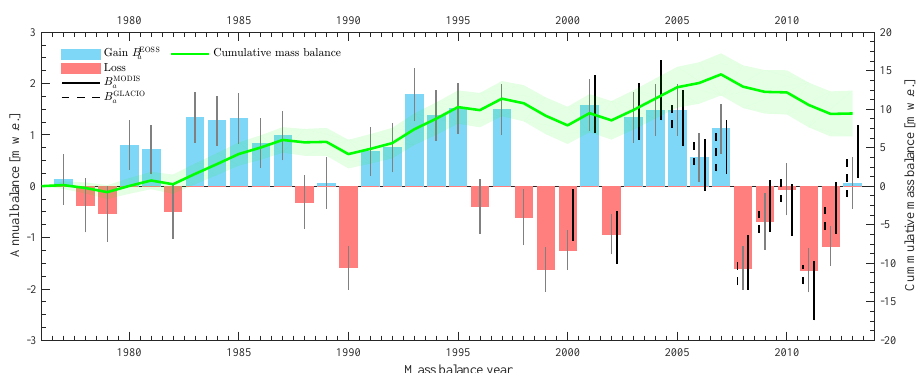
Figure 14. Comparison between the observed annual balance measurements (2005–2013) and the two reconstructed annual balance records. The first reconstruction (Model M1) is based on minimum albedo values (2000–2013), while the second reconstruction is based on EOSS values (1977–2013). Also shown is the cumulative mass balance of Brewster Glacier (1977–2013), based on the annual records reconstructed from EOSS